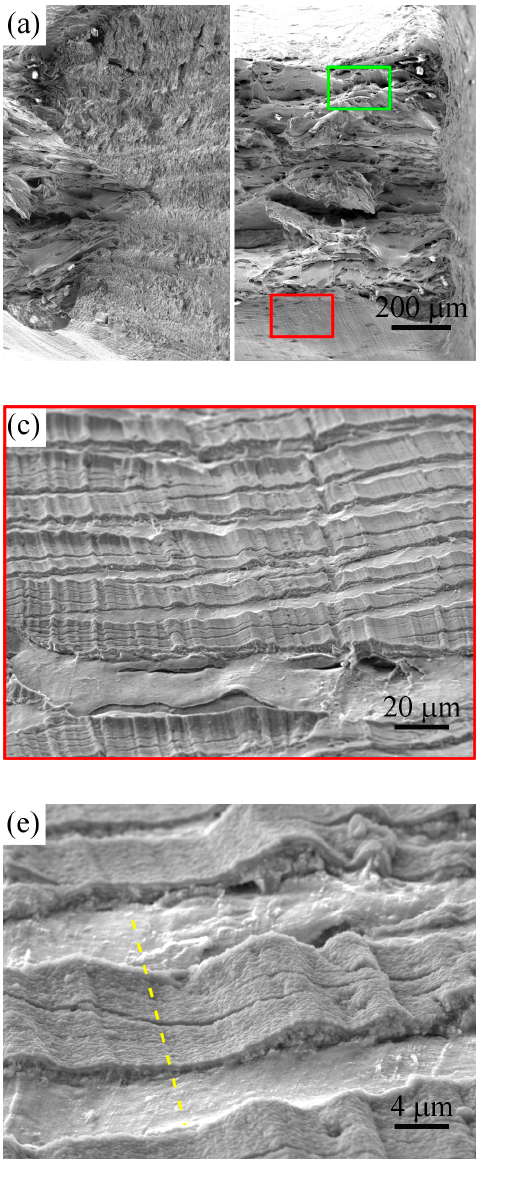
Figure 8. The fracture surface of the sample loaded using the incremental step test where the fracture occurred after 84 cycles at the highest level of strain amplitude ( ε a = 0.6%): ( a ) overview in macroscopic scale; ( b ) tongue like features; ( c , e ) lower and higher magnification micrograph of a wavy pattern of the oxide layer on the surface of gauge length near the fracture surface; ( d , f ) ductile dimples between the V-shaped troughs.